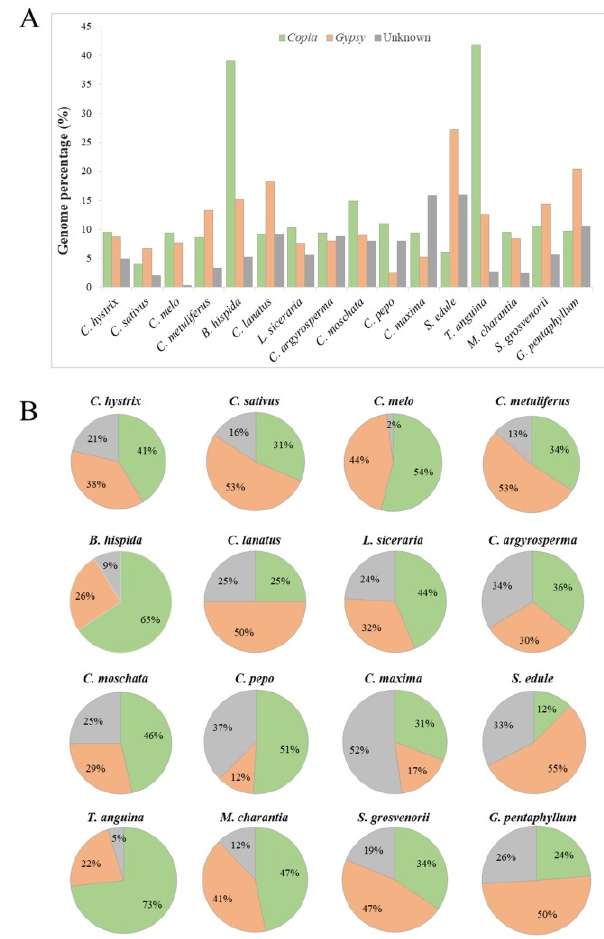
Figure 3. LTR ‐ RT annotation of the genomes of 16 Cucurbitaceae species. ( A ) Genome proportion of Copia , Gypsy , and Unknown elements of each species. ( B ) Proportion of Copia , Gypsy , and Unknown elements in LTR ‐ RT fractions in each species.